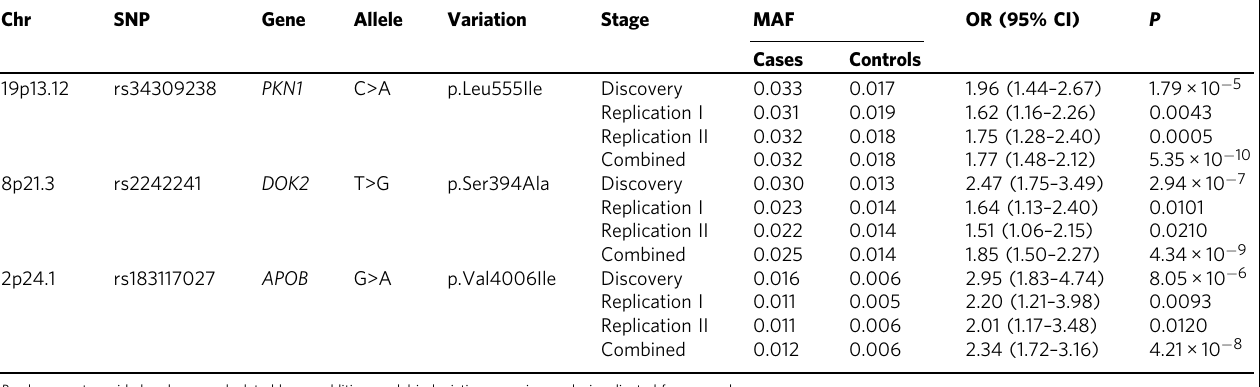
Table 1 The identi fi ed variants associated with pancreatic cancer risk in the discovery, replication and combined samples Chr SNP Gene